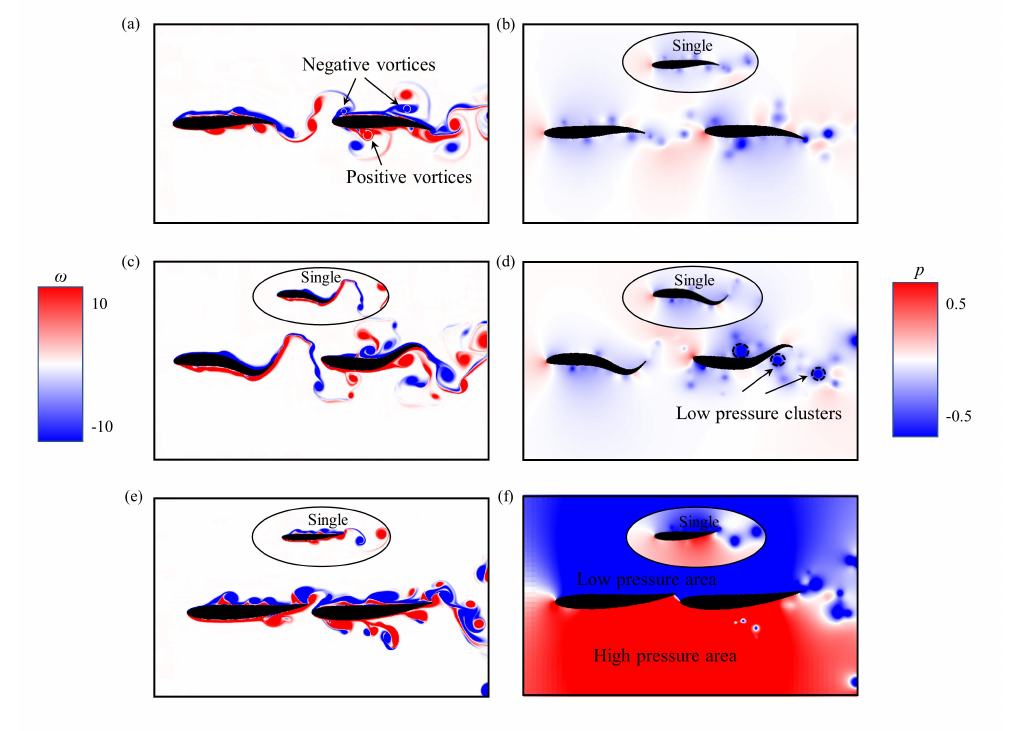
Figure 7. Instantaneous vorticity contours and pressure contours of two self-propelled fish in the tandem formation at swimming parameters ( a , b ) A = 0.1 L , λ = 2.0 L , δφ = π /4, ( c , d ) A = 0.2 L , λ = 1.0 L , δφ = 3 π /4, and ( e , f ) A = 0.1 L , λ = 8.0 L , δφ = π /4. Other parameters are the same: T = 1.0 T c and d 0 = 0.5 L .